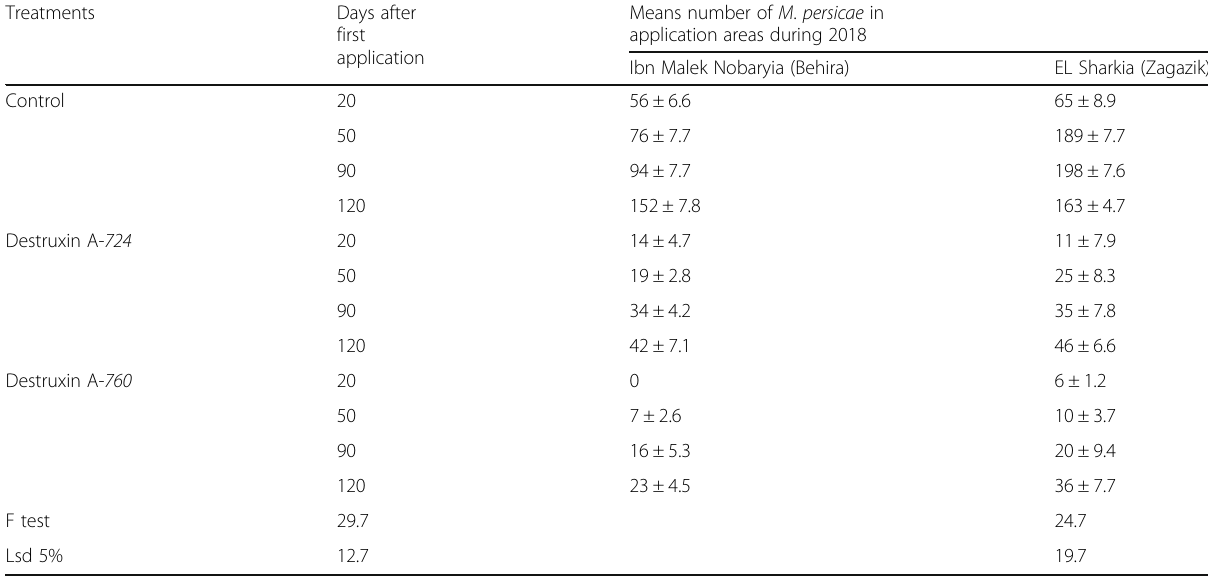
Table 2 The infestation of tomato plants with M . persicae after treatment with Destruxin A-724 and Destruxin A-760 under field